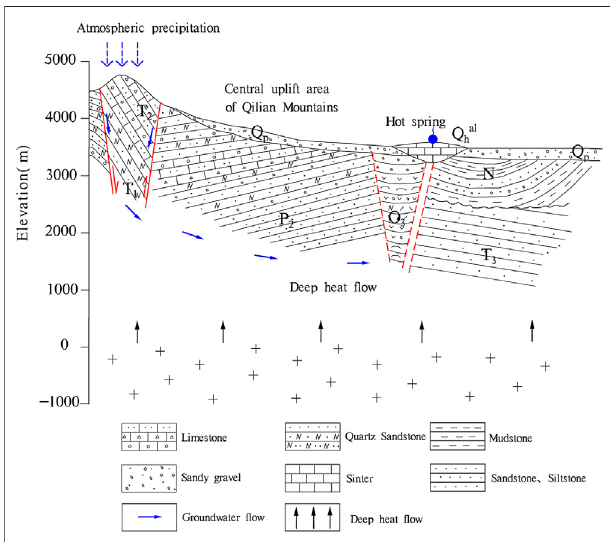
FIGURE 9 | Genetic model of warm spring B11 in the Jiangcang